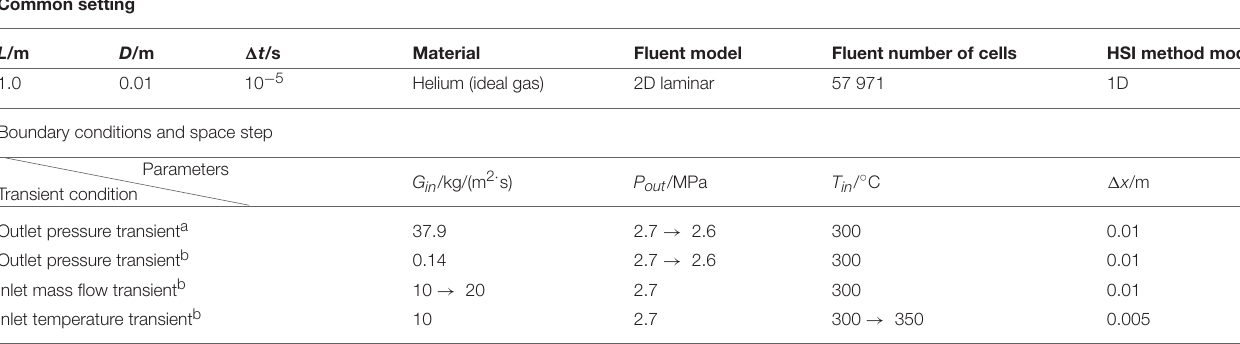
TABLE 1 | Parameter settings. Common setting